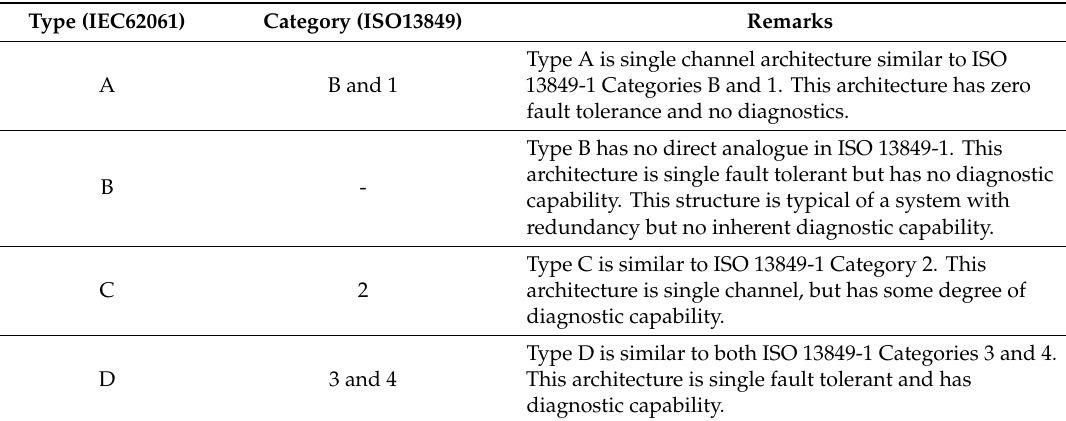
Table 14. System architectures used in the analysis of random hardware failures based on two